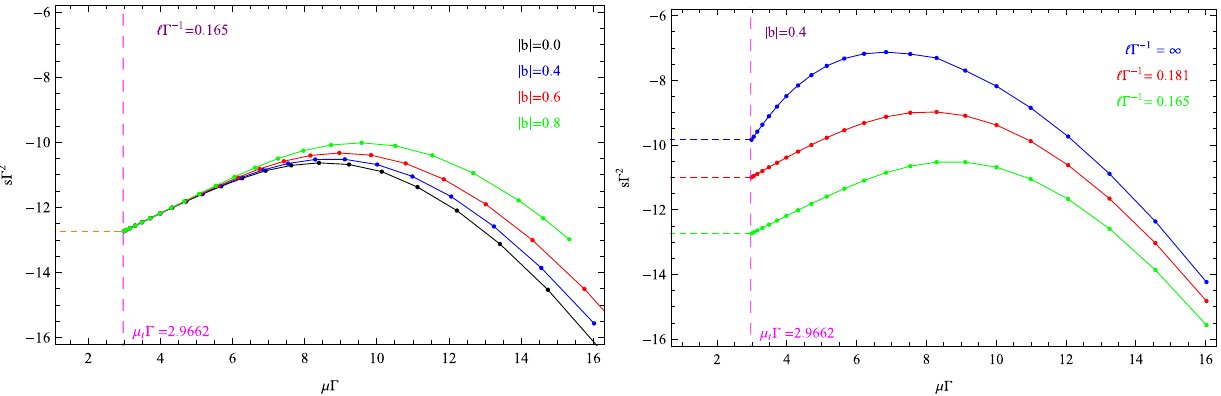
Fig. 3 The HEE s with respect to the chemical potential μ for various factors. The left-hand figure is the case of (cid:2)(cid:8) − 1 = 0 . 165 with different LEN parameter b . The four curves in the figure from button to top cor- respond to increasing | b | , i.e., | b | = 0.0 (black), 0.4 (blue), 0.6 (red) and